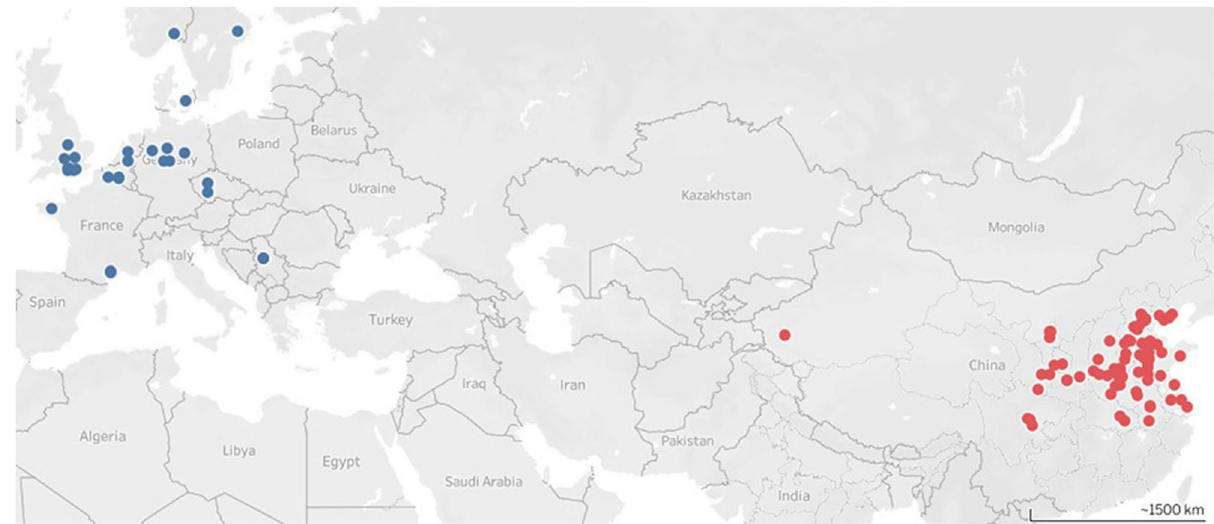
Fig. 7 Site locations. Geographical distributions of wheat aphids included in this study of wheat aphid loads in China and Europe. Red circles (2141 data points) represent studies from China and blue circles (1169 data points) represent studies from